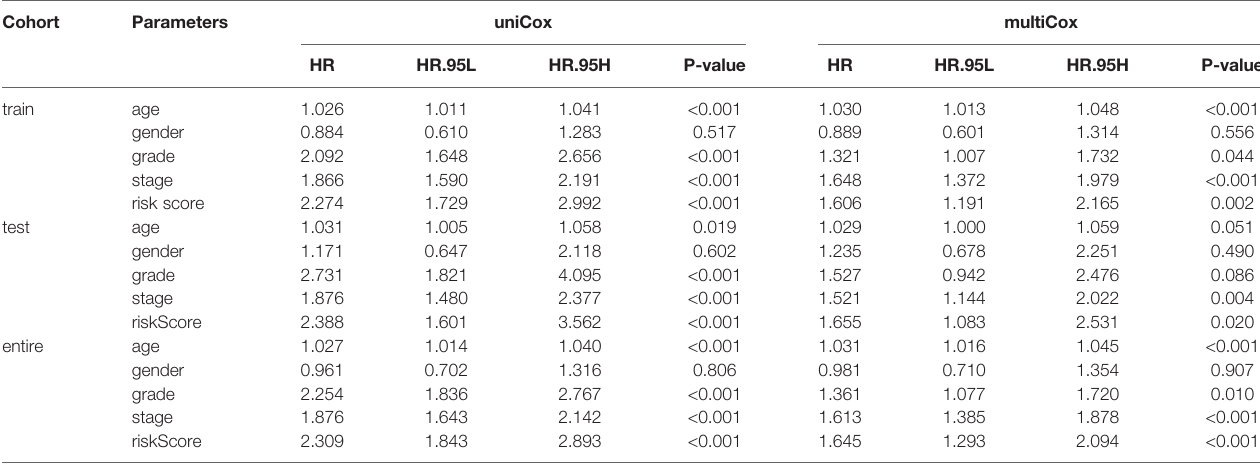
TABLE 3 | Independent prognostic analysis in three cohorts of TCGA KIRC dataset. Cohort